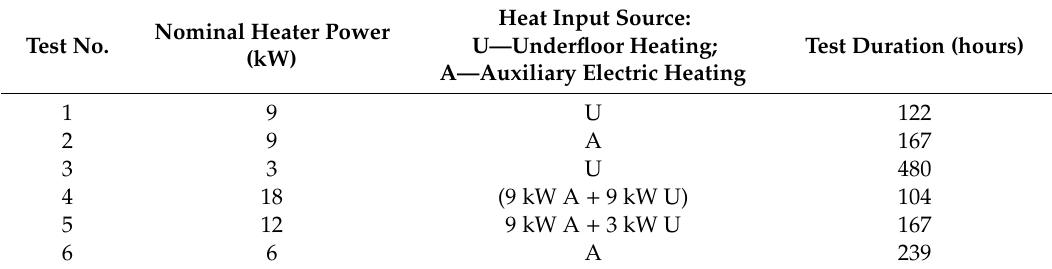
Table 1. Schedule of dynamic heating tests.